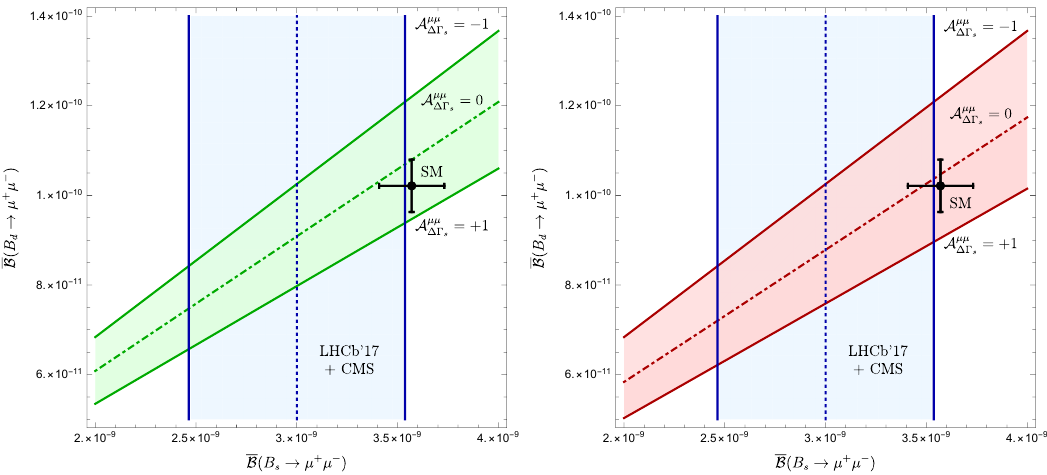
( B d (cid:22) + (cid:22) (cid:0) ) and ( B s (cid:22) + (cid:22) (cid:0) ) in B ! B ! (cid:22)(cid:22) between (cid:1)(cid:0) s A